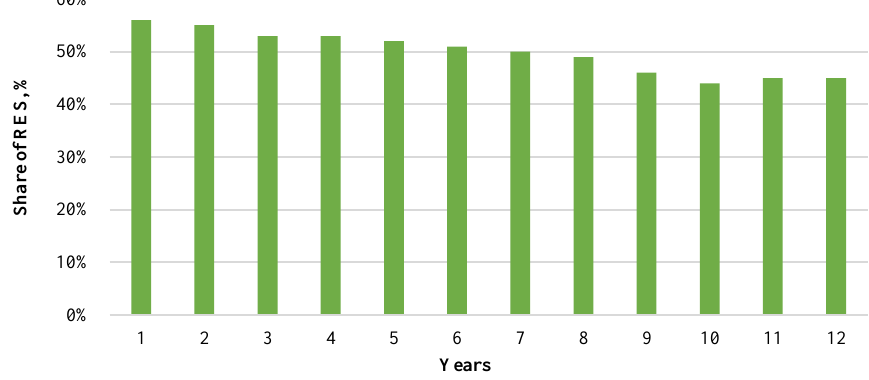
Fig. 1. Share of wood and other solid biomass in renewable energy in EU (2005–2016)